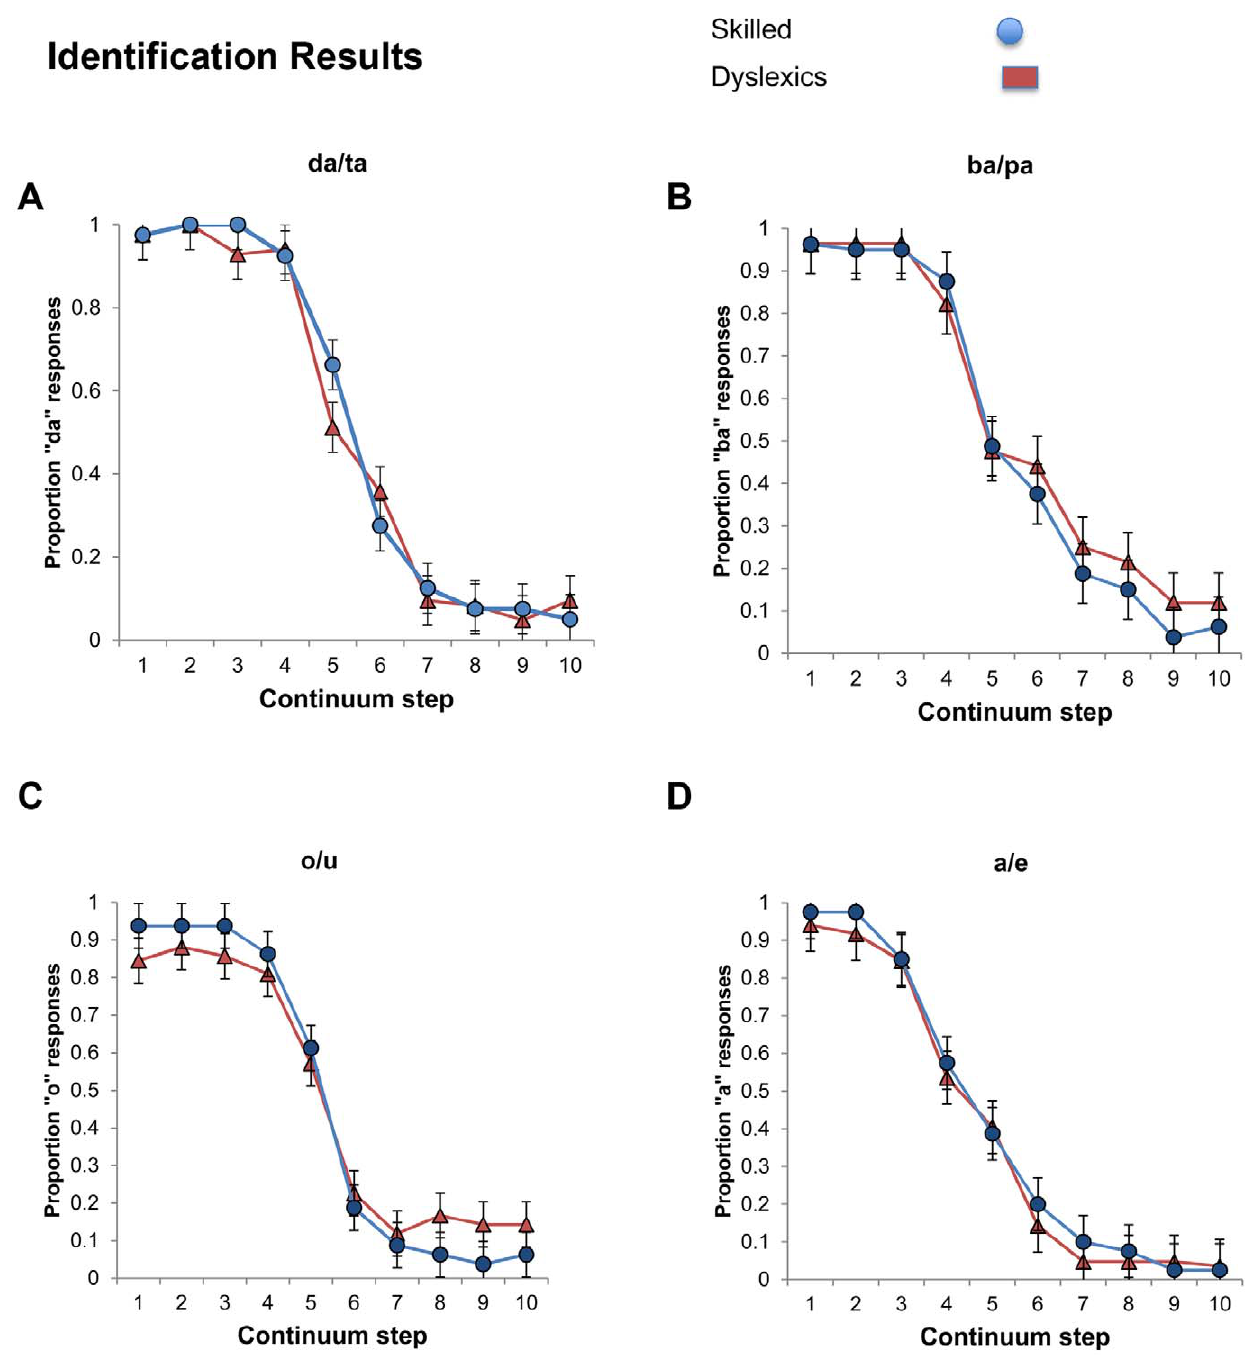
Figure 3. Phonetic identification of consonants and vowels by skilled readers and dyslexics along a 10-step continuum. Step continuum denotes the target stimulus. Error bars reflect confidence intervals for the difference between the group means.